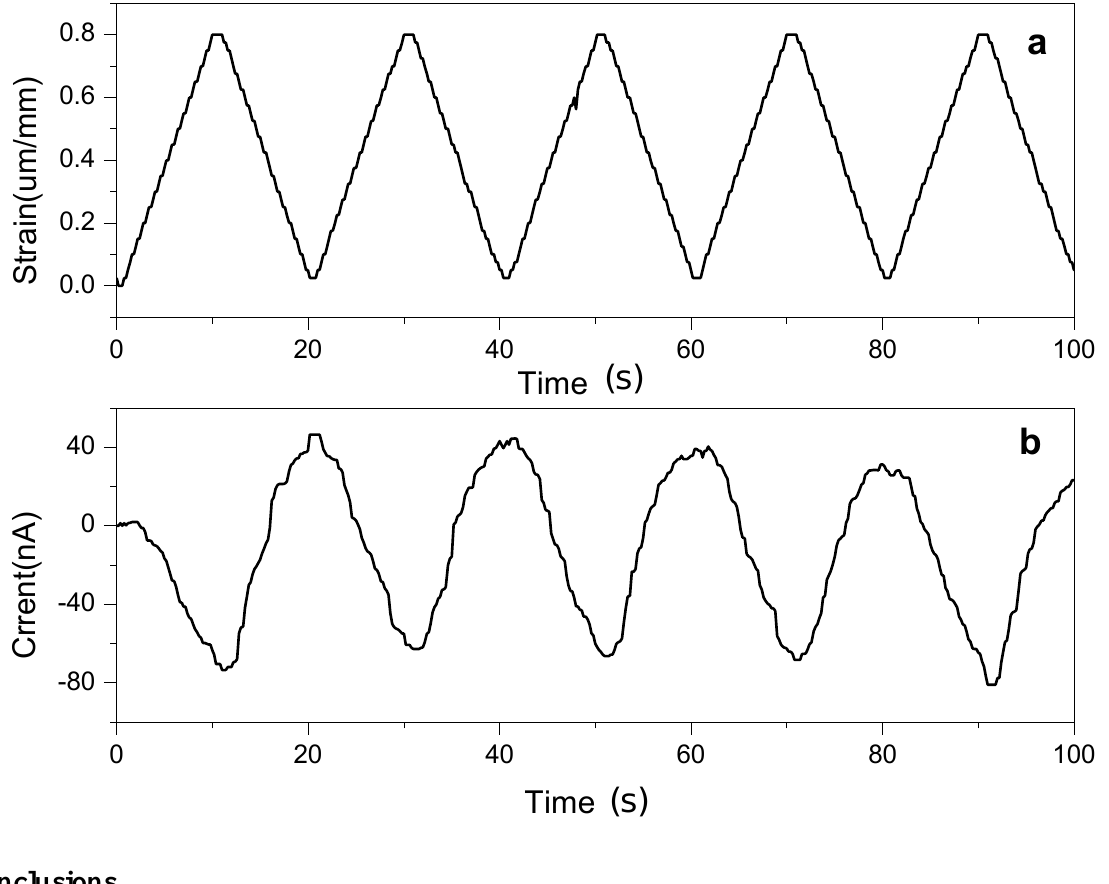
Figure 8. Stretching mode strain sensor: ( a ) stretching strain and ( b ) sensor